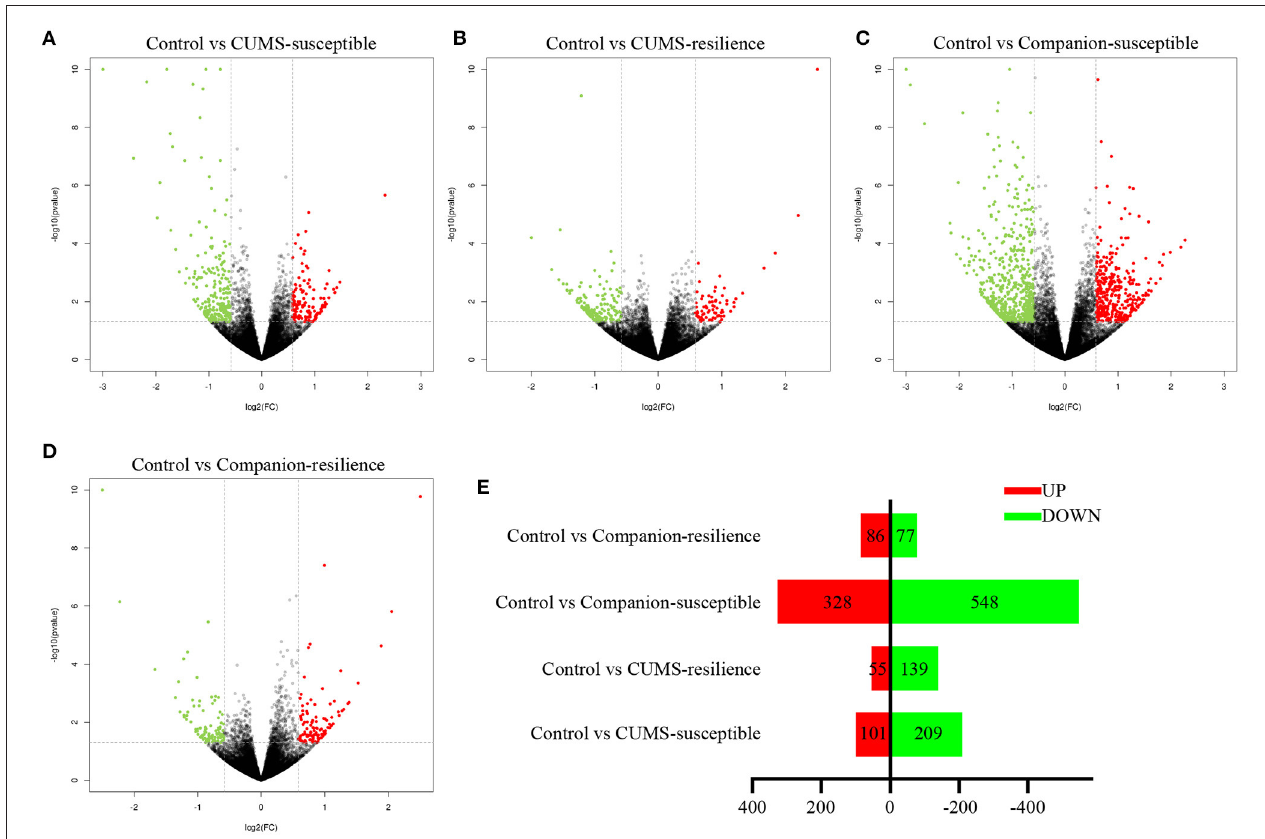
FIGURE 2 | mRNA expression profiles of VTA in Control, CUMS-susceptible, CUMS-resilience, Companion-susceptible, and Companion-resilience mice. (A–D) The MA plot displays the DEGs distribution between Control mice and CUMS-susceptible mice, CUMS-resilience mice, Companion-susceptible mice, Companion-resilience mice, respectively. (E) The column chart shows the number of statistical